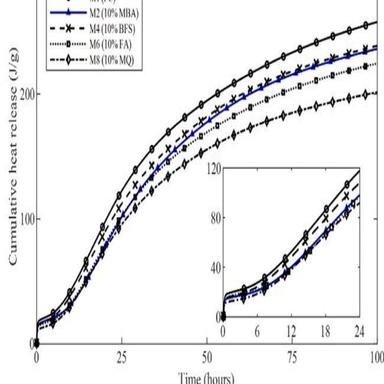
Flow diameters of mortar mixtures with different substitute materials (Results were taken as the average of two measurements, the error bar represents the standard deviation).